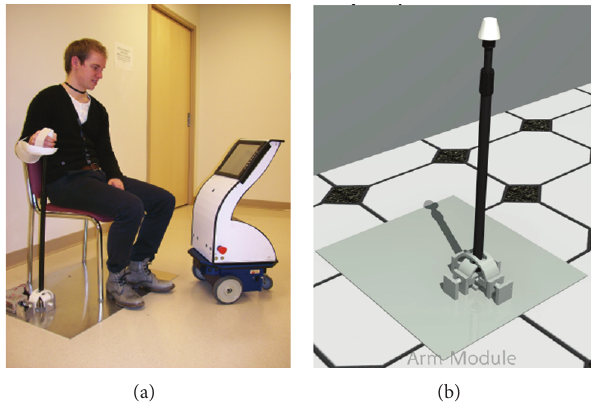
Figure 2: Arm module. (b) adjustable pole allowing 2 degrees of rotation type device. (a) Demonstrating user interacting with